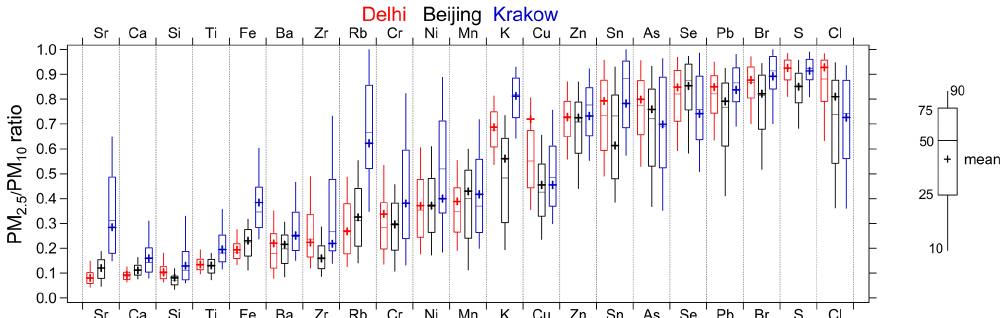
Figure 3. Box-and-whisker plots of the measured elemental PM 2 . 5 / PM 10 ratios at Delhi, Beijing, and Krakow (see Fig. S4 for all four sites). Box: first to third quartile range; − : median line; + : mean; whiskers: 10%–90% percentiles.